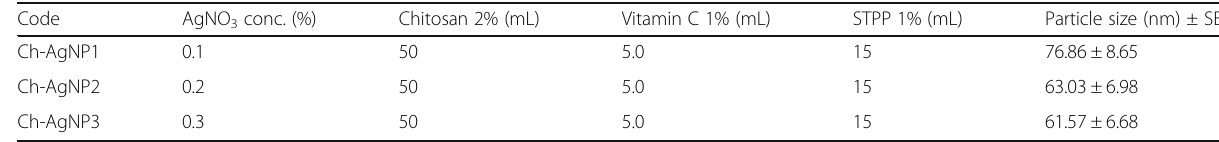
Table 1 Preparation conditions and characterizations of silver and chitosan nanoparticles Code AgNO 3 conc. (%) Chitosan 2% (mL) Vitamin C 1% (mL) Ch-AgNP1 0.1 Ch-AgNP2 0.2